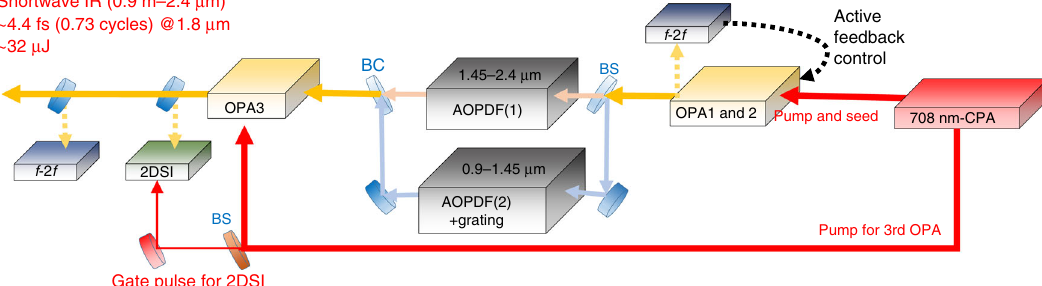
Fig. 1 Schematic setup for the OPA system used to amplify sub-cycle SWIR pulses. A laboratory-built Ti:sapphire CPA system delivered 708-nm pulses as the driving source for the three subsequent OPA stages. Between the second and third stages, an MZI was set to divide and synthesize the spectrum for dispersion management with two AOPDFs, one placed in each arm. Part of the pumping energy was used for the pulse characterization (2DSI) system. The relative CEP for the ampli fi ed pulses from OPA2 was determined using an f – 2 f interferometer and the error signal was fed back to the controller, which adjusted the delay between the pump and seed pulses in OPA1 to stabilize the CEP. 2DSI two-dimensional shearing interferometer, BS beam splitter, BC